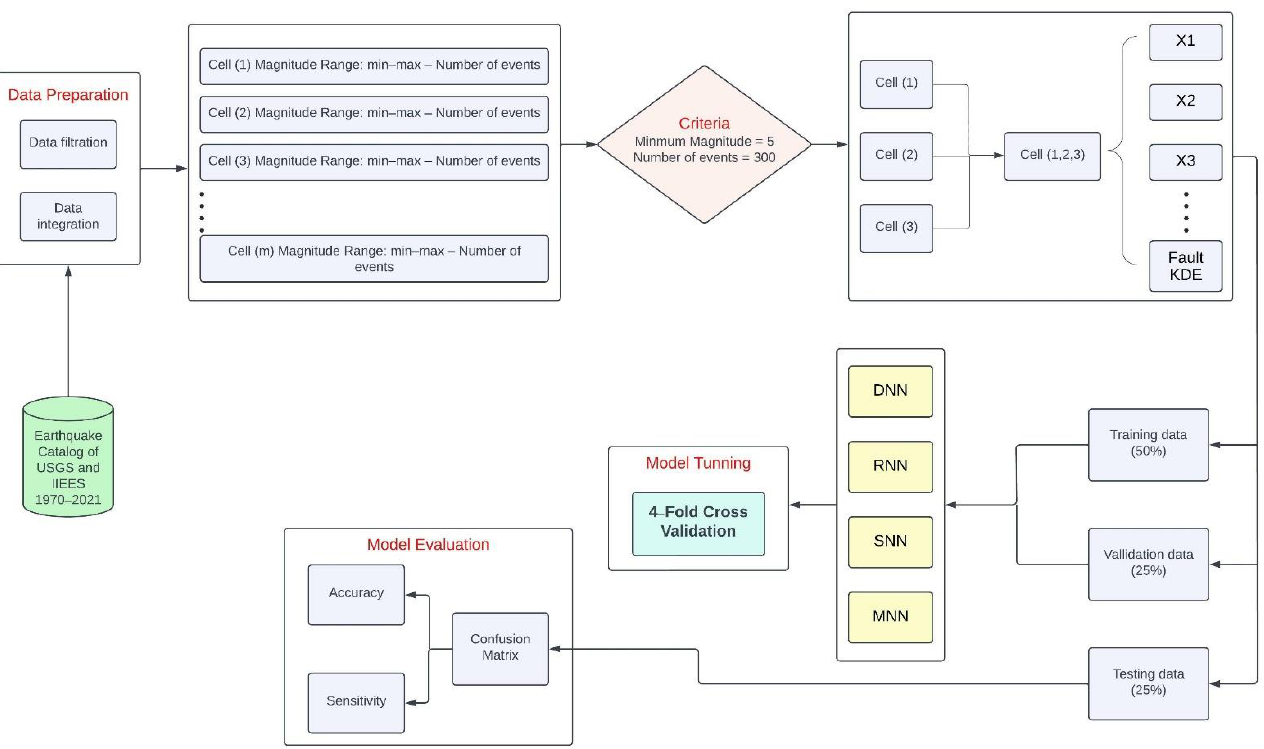
Figure 1. The methodological framework of the